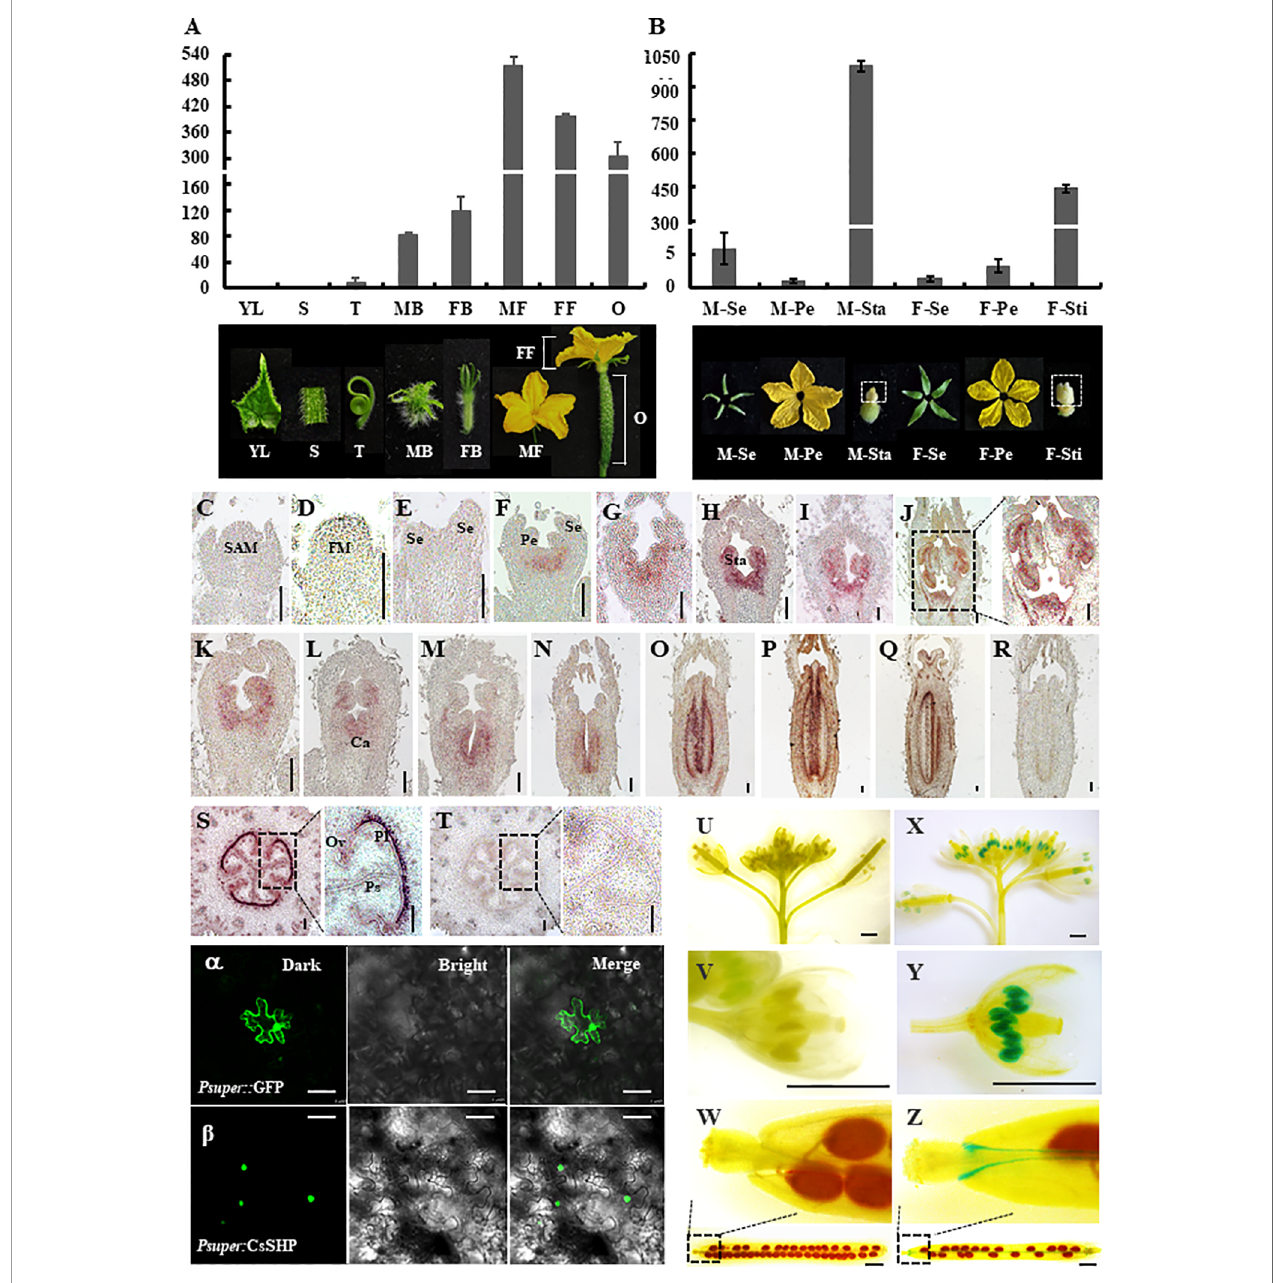
FIGURE 3 | Expression analysis and subcellular localization of CsSHP . (A) quantitative real-time (qRT)-PCR analysis of CsSHP expression in different cucumber organs. YL, young leaves; S, stems; T, tendrils; MB, male buds; FB, female buds; MF, male fl owers at anthesis; FF, female fl owers at anthesis; O, ovaries at anthesis. Three biological replicates and three technical replicates were performed. (B) qRT-PCR analysis of CsSHP expression in different fl oral organs at anthesis. M-Se, sepals from male fl owers; M-Pe, petals from male fl owers; M-Sta, stamens from male fl owers; F-Se, sepals from female fl owers; F-Pe, petals from female fl owers; F-Sti, stigmas from female fl owers. Three biological replicates and three technical replicates were performed. Pictures of the corresponding organs are displayed at the bottom. (C – T) In situ hybridization of CsSHP in young organs of cucumber. Scale bar = 100 m m. (C) Shoot apical meristem (SAM). (D – H) Longitudinal sections of male fl ower buds at stages 1 – 5 in inbred line R1461. (I, J) Male fl ower buds at stages 8 and 9 in R1461 line. (K – Q) Longitudinal sections of female fl ower buds at different developmental stages in inbred line R1461. (S) Transection of ovary 10 days before anthesis. (R, T) The sense CsSHP probe was hybridized as a negative control. FM, fl oral meristem; Se, sepal; Pe, petal; Sta, stamen; Ca, carpel; Pl, placenta; Ps, pseudoseptum; Ov, ovule. (U – Z) b - Glucuronidase (GUS) signals of CsSHP in Arabidopsis . Scale bar = 1 mm. (U – W) Negative control plants showed no GUS signal. (X, Y) GUS signals were highly enriched in stamens. (Z) GUS signals were detected in valve margin of silique. The experiment was repeated three times. ( a , b ) Subcellular localization of CsSHP. GFP signals were localized in the nucleus. GFP driven by the pSUPER promoter was used as a positive control. GFP is shown in green. The left, middle, and right panels represent pictures taken under dark fi eld, bright fi eld, and merge views, respectively. Scale bar = 50 m